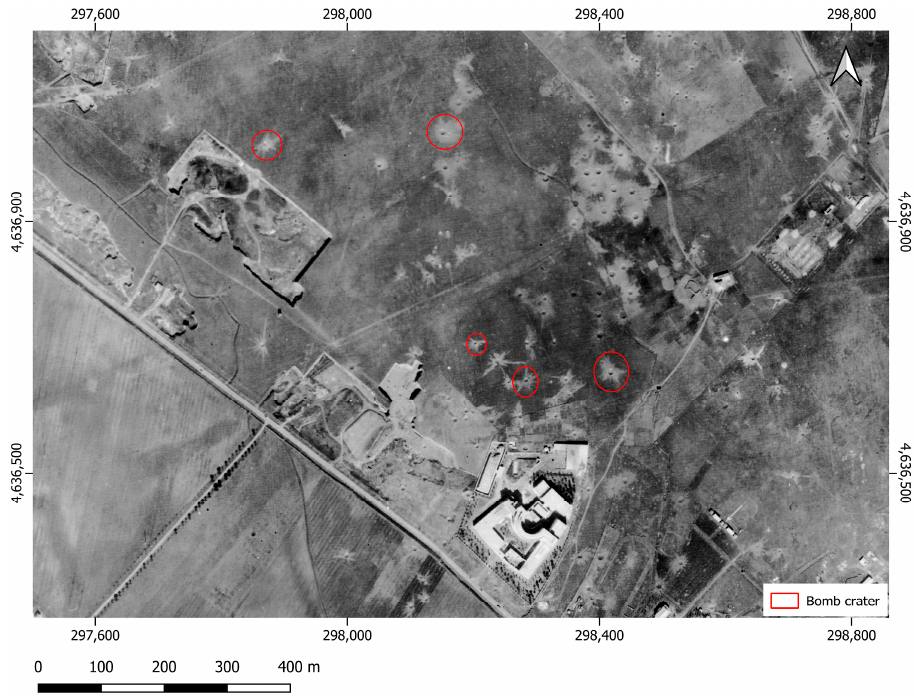
Figure 3. Craters left by the bombardments of 1944 visible in a historical photograph (RAF_1944). Some of them are circled in red to exemplify their appearance. Photographs from © Istituto Centrale per il Catalogo e la Documentazione (ICCD)-Aerofototeca Nazionale, Fondo RAF, flight 1944.